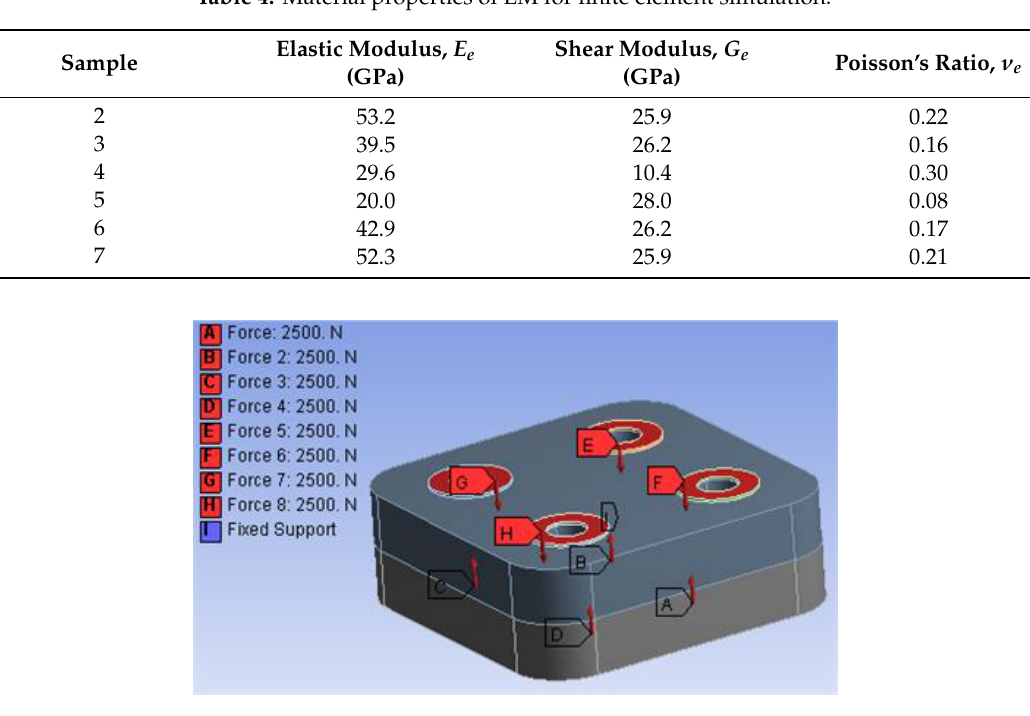
Figure 6. Loads and constraint for bolted structure.